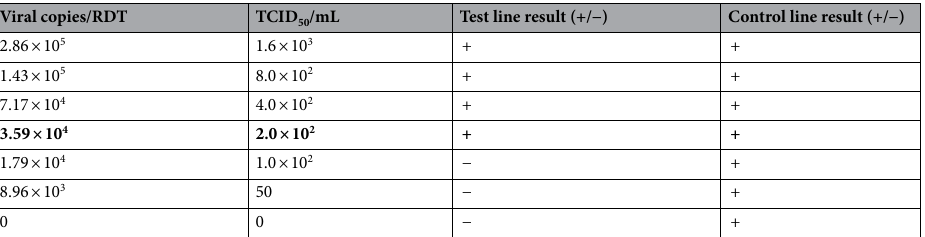
Table 1. Linearity study summary. The dilution in bold (3.59 x 104 viral copies/RDT, 2.0 x 102 TCID50/mL) was the lowest detectable dilution in the series. Visually interpreted test results of heat inactivated reference visible test line and were interpreted as negative. All test cassettes have a visible red control line, indicating all tests were valid.